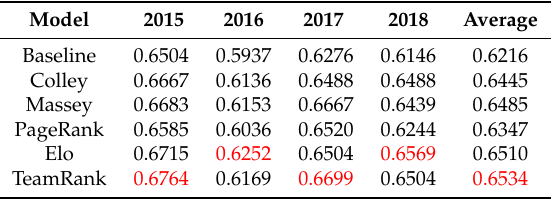
Table 4. Prediction accuracy of the results. Red values indicate the highest prediction accuracy for each